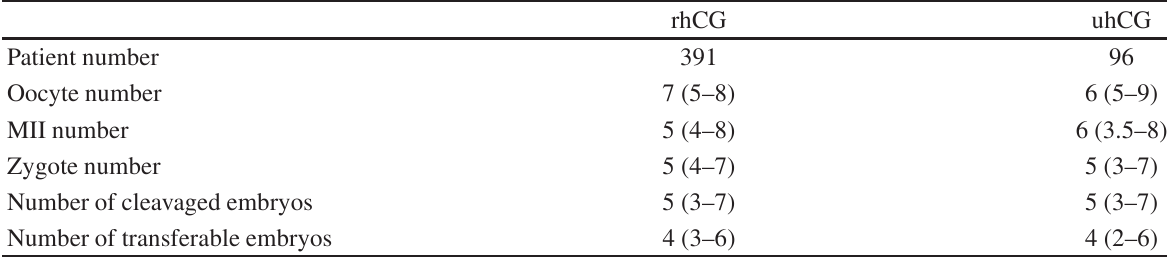
TABLE 3: Oocyte, MII, zygote, and embryo numbers with rhCG and uhCG products in assisted repro- duction. Data are presented as median, interquartile